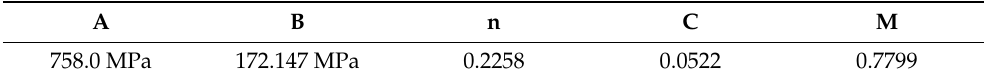
Table 2. Johnson–Cook Parameters for Maraging Steel M300 According To